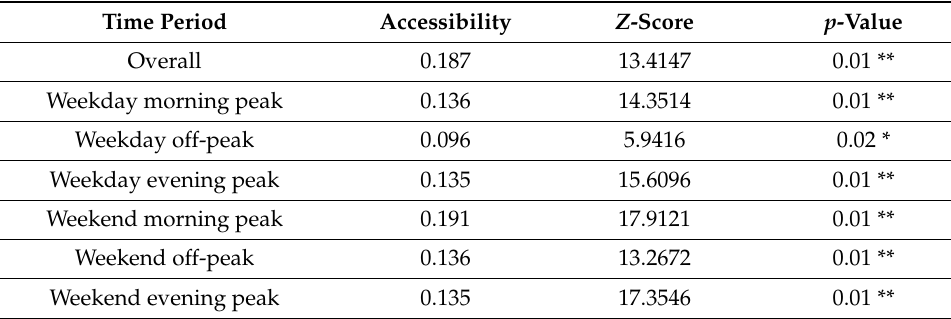
Table 2. Indicators related to the Moran’s I of